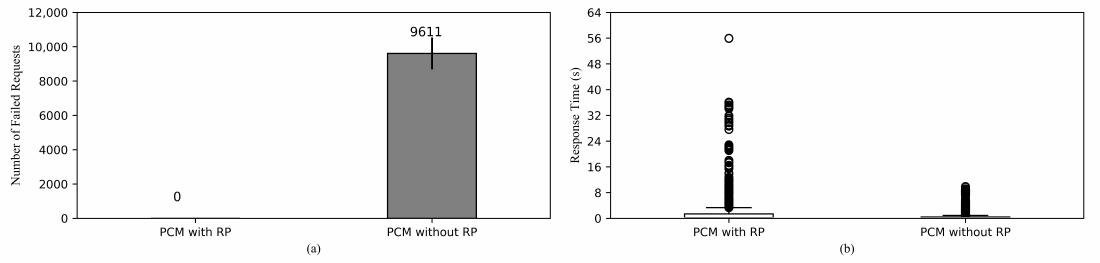
Figure 9. Comparison of HPA performances with and without Readiness Probe. ( a ) The total number of the failed requests. ( b ) Response time of the successful